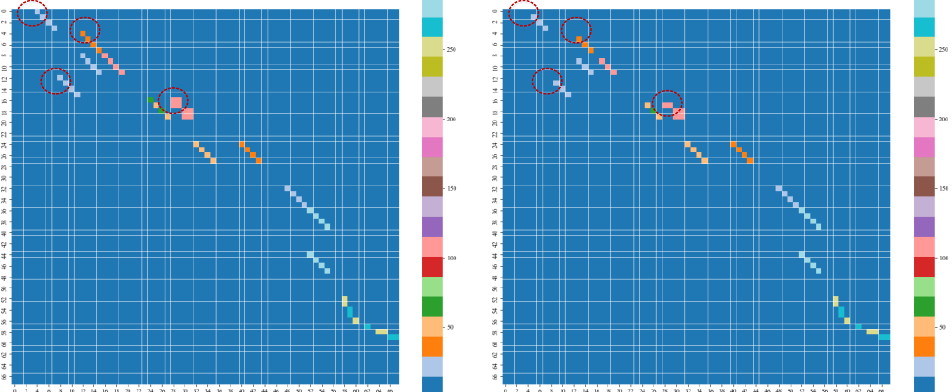
Figure 17. Comparison graph of normal state-associated fault mode graph before and after missing parameters.